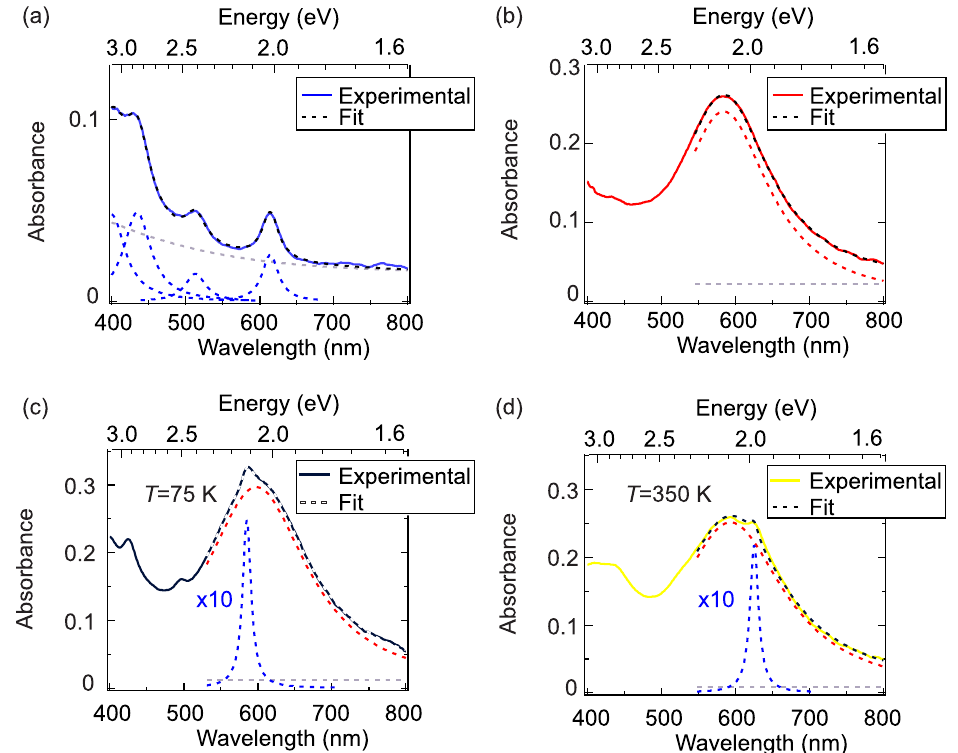
Figure A2. Deconvolution of the micro-absorbance spectra of ( a ) ML-WS 2 /LiF (solid blue), ( b ) Au NPs/LiF (solid red), ( c ) ML-WS 2 /Au NPs/LiF at T = 75 K (solid black) and ( d ) ML-WS 2 /Au NPs/LiF at T = 350 K (solid yellow). In the graphs, the dashed grey lines correspond to the backgrounds, the dashed blue peaks to excitonic features (multiplied by 10 in panels ( c , d )), the dashed red peak to the plasmonic resonance and the black dashed lines to the fitting curves (dashed white curve in the graph of panel ( c ))